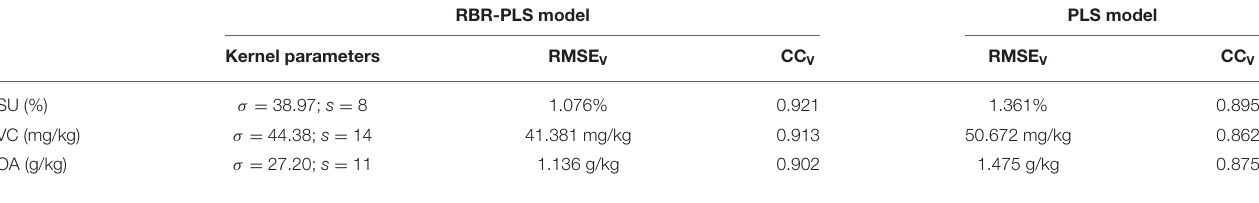
TABLE 2 | The optimal RBF-PLS models for NIRHI prediction of SU, VC, and OA contents in pomelo fruit